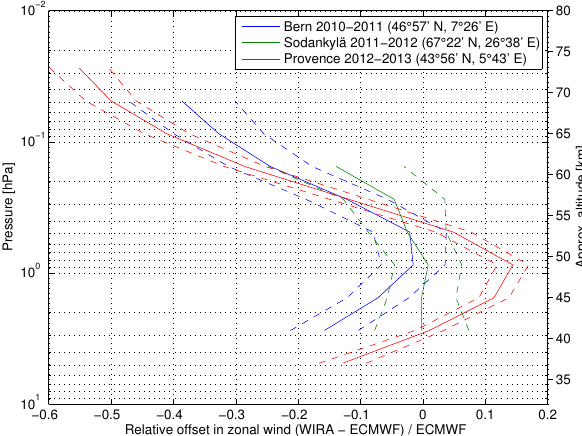
Figure 18. Relative difference between the average profiles of WIRA and ECMWF for the measurement campaigns in Bern, So- dankylä and Haute-Provence. The dashed lines represent the errors of the mean wind profiles from WIRA. The data from ECMWF have been convolved with WIRA’s averaging kernels. Results are only shown within the trustable altitude range of the